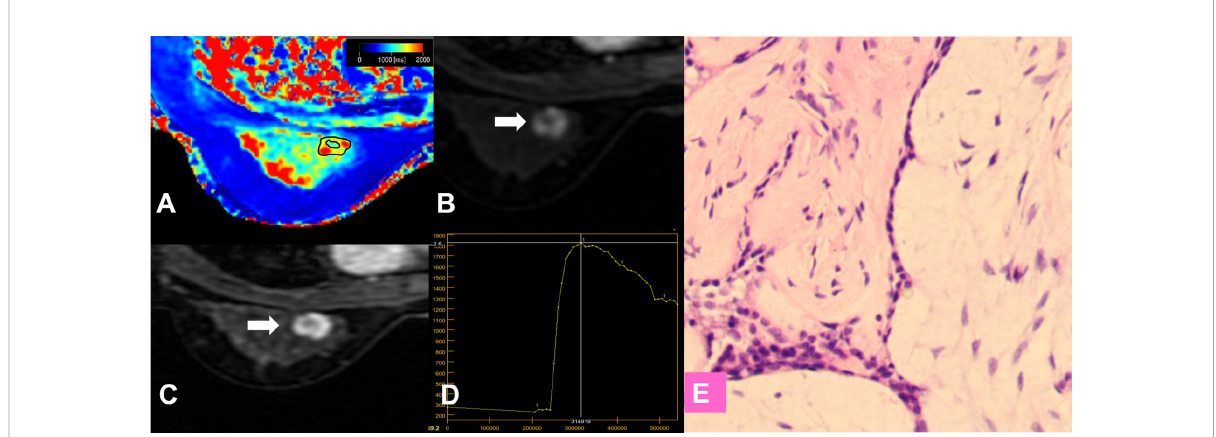
FIGURE 7 False-positive lesion identi fi ed by the KS. (A – E) A 27-year-old female patient: MRI showed a mass lesion in the left breast [ (B, C) , white arrow]. The lesion showed no root sign, inhomogeneous enhancement (B, C) , and a washout enhancement curve type (D) . (A) T1 map, (B) Early contrast-enhanced MRI, (C) Delayed contrast-enhanced MRI, (D) TIC curve, (E) Pathological image (H&E, 100×). The Kaiser score was 8 and was classi fi ed as positive for malignancy. The T1 relaxation time was 1727.16 ms, which was higher than the cutoff value of 1595.94 ms. The combined diagnosis using the KS and T1 value identi fi ed a benign lesion. Histopathology revealed a fi broadenoma (E)